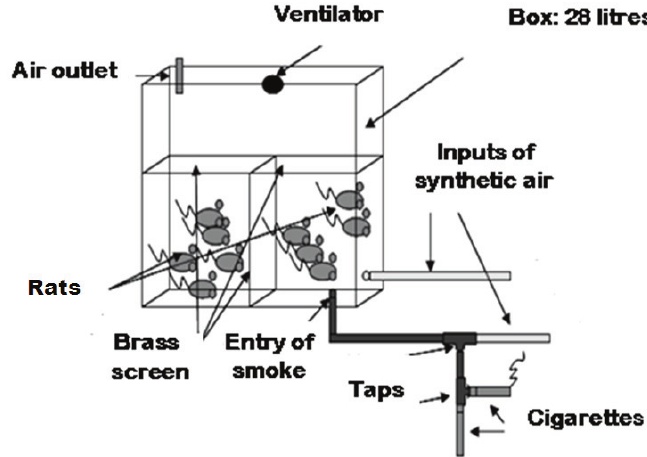
FIGURE 1 - Chamber of exposure do cigarette smoke (Bizelli 11